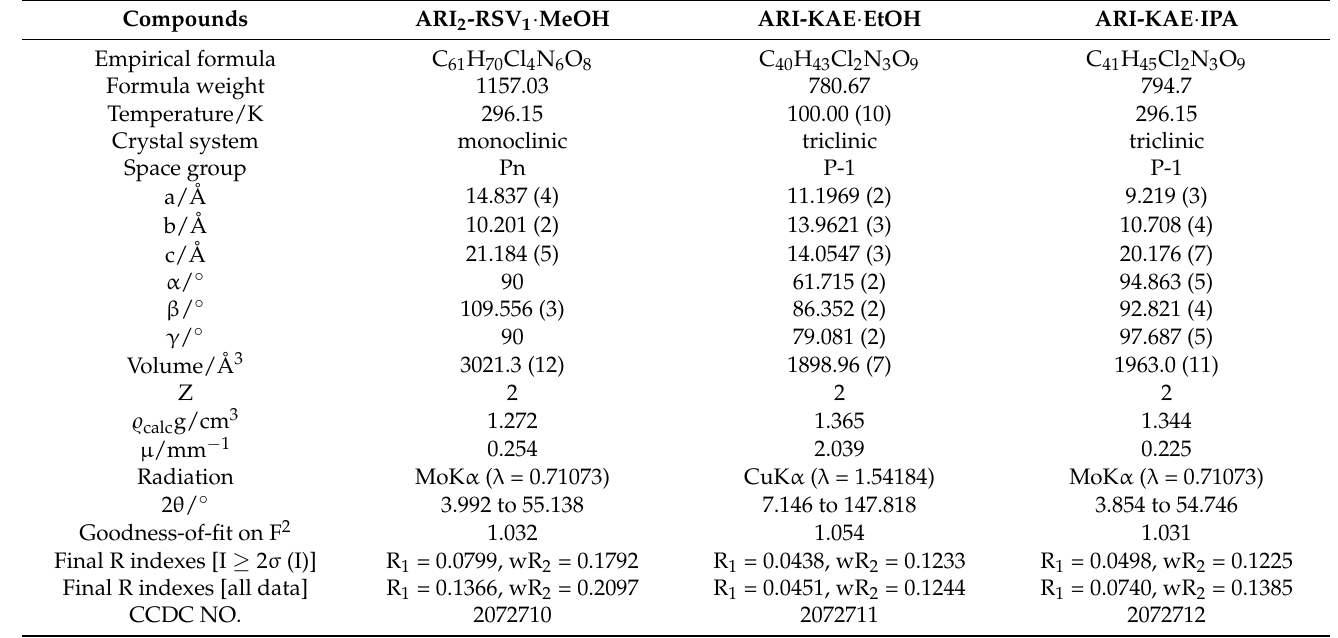
Table 1. Data Collection and Refinement Parameters for the